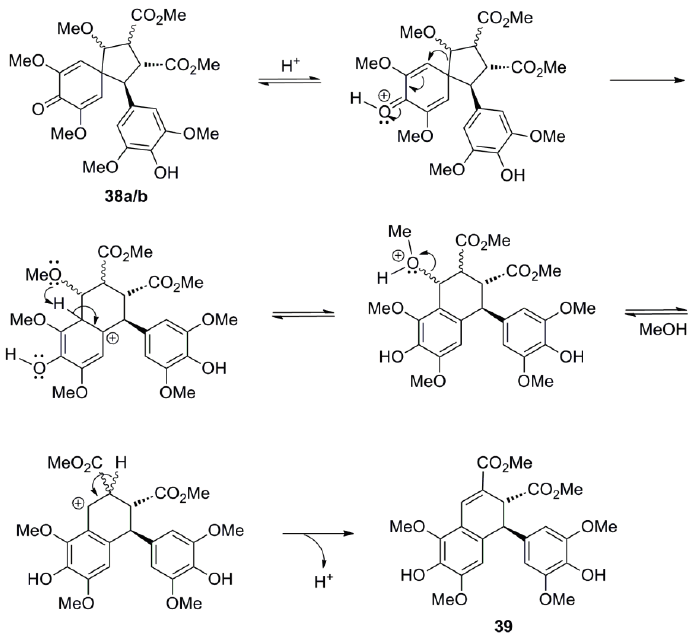
Scheme 25. Outline of the plausible mechanism for the conversion of products 38a , b to 39